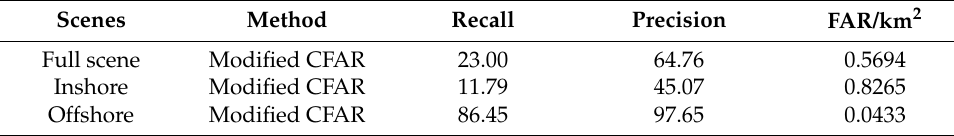
Table 8. The results of traditional ship detection methods on the test set. Scenes Method Recall Precision FAR/km 2 Full scene Modified